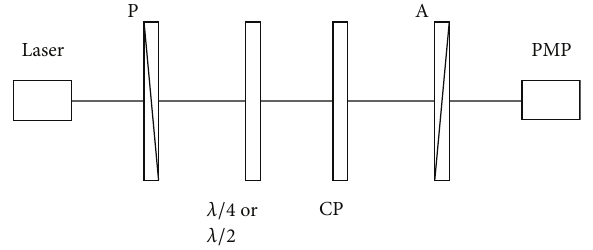
Figure 1: The experimental setup. P = polarizer; A = analyzer; 𝜆 , 𝜆/4 or 𝜆/2 = standard crystal plate; CP = investigated crystal plate; PMP = photomultiplier.